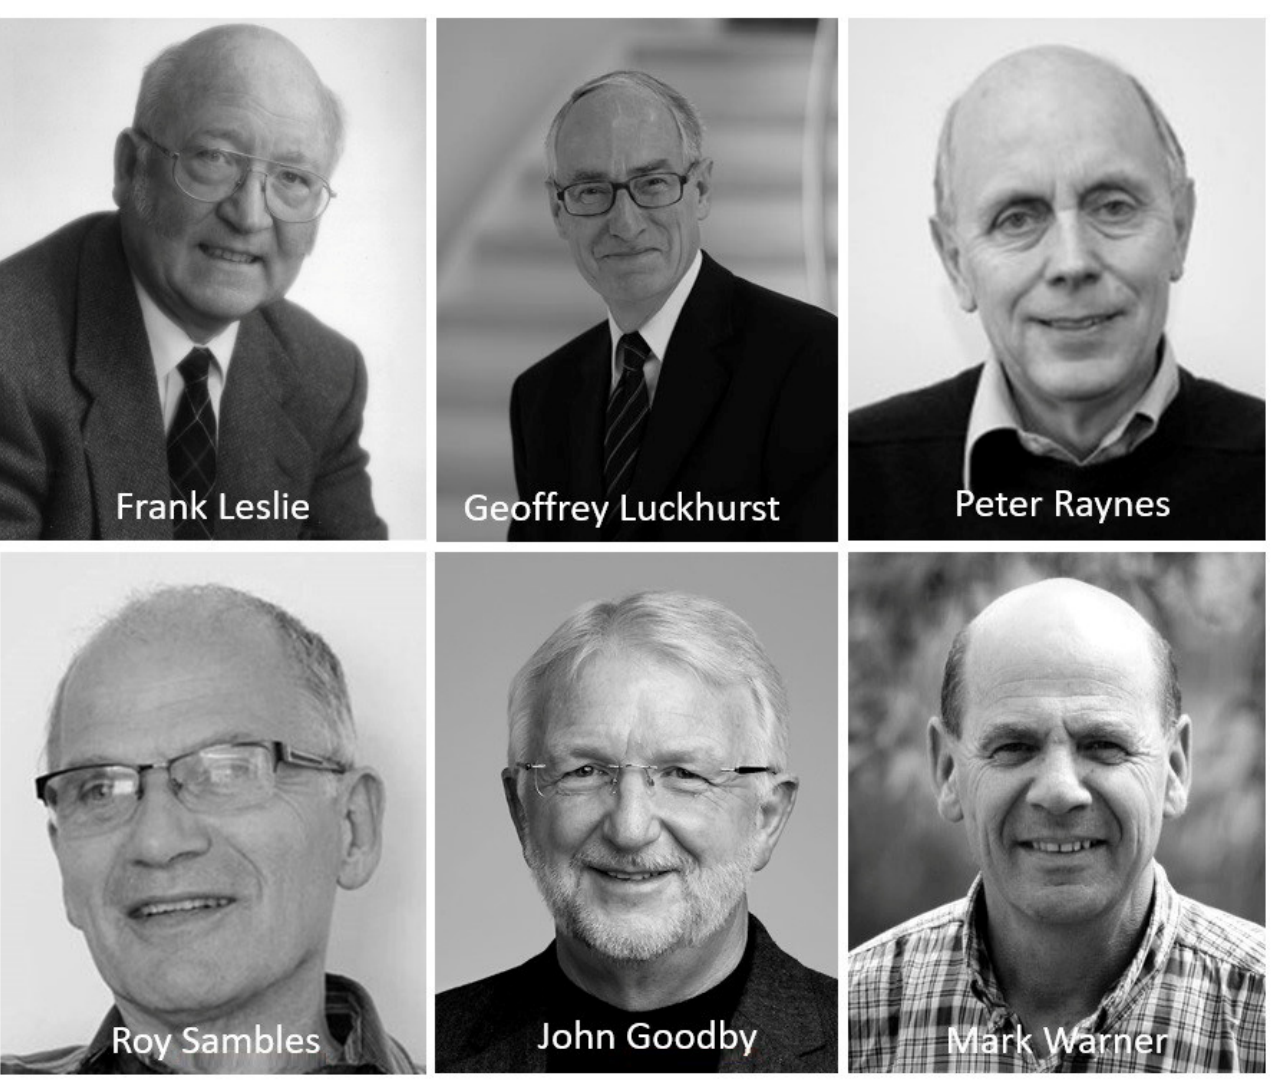
Figure 7. The next generation of UK liquid crystal researchers who made seminal and